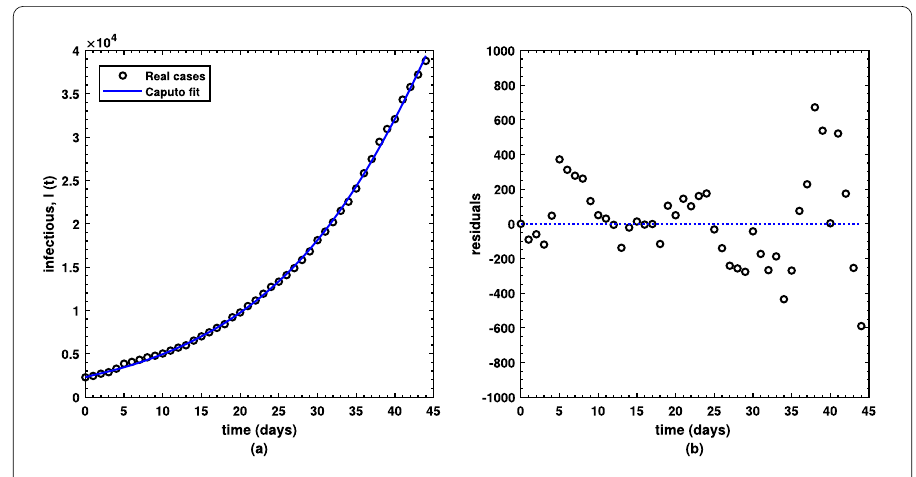
Figure 2 ( a ) Best data fitting for COVID-19 daily cases (black circles) in Pakistan from 1 April to 15 May 2020 with the infectious class I ( t ) (solid blue line) of the model under the Caputo operator ( ν = 8.561591e-01) and the ( b ) respective residuals